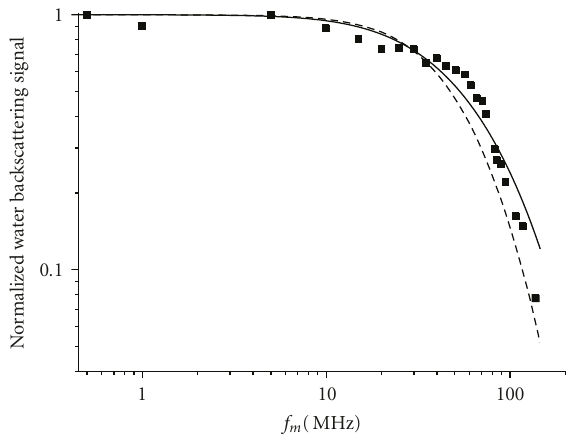
Figure 4: Normalized optical noise versus f m for k = 0 . 88m − 1 . Filled squares represent the experimental measures. The other curves were obtained by means of the theoretical model with r rec = 0 . 2m, θ FOV = 0 . 117rad, r 0 = 0 . 025m and the following values for the other parameters: (1) k (cid:6) = k = k d (dashed line); (2) k (cid:6) = 0 . 268m − 1 , k f s = 0 . 612m − 1 , (cid:13) θ 2 (cid:14) = 0 . 116 (solid